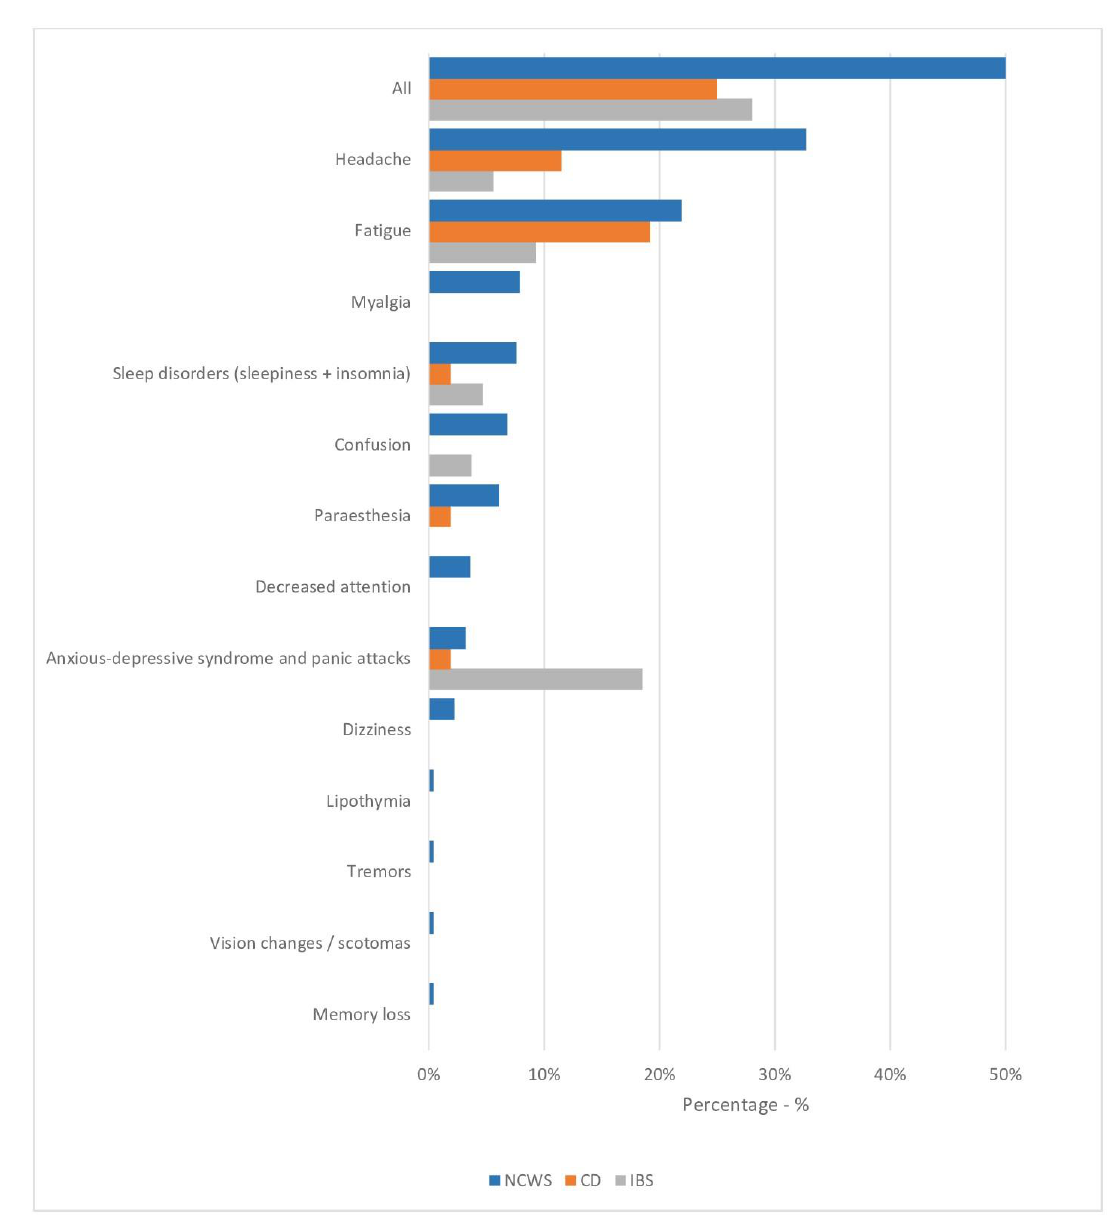
Figure 1. Frequency of each neurologic and psychiatric symptom in NCWS patients ( n = 278) and in CD ( n = 52) and IBS ( n = 54) controls included in the study. Data are expressed as percentages.